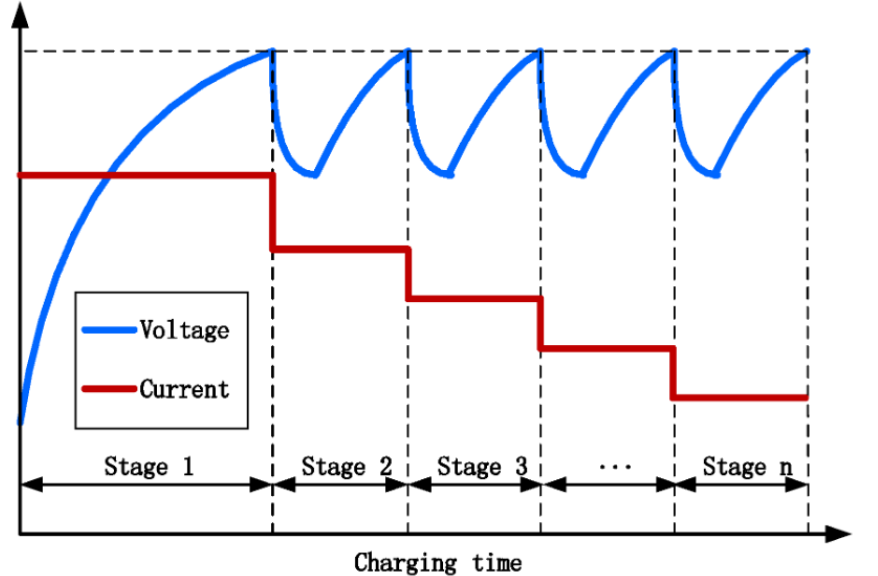
Figure 31. Profile of the Multi-stage Constant-Current battery-charging strategy.